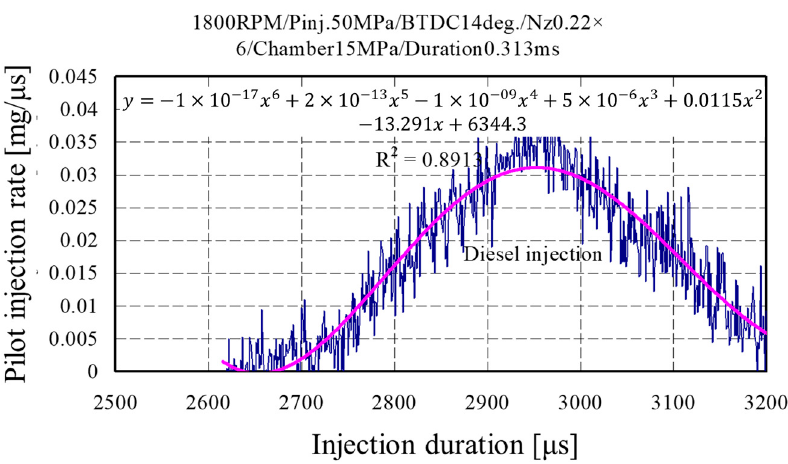
Figure 12. Injection rate characteristic for only the pilot injection quantity of the pilot and main injection durations for diesel.